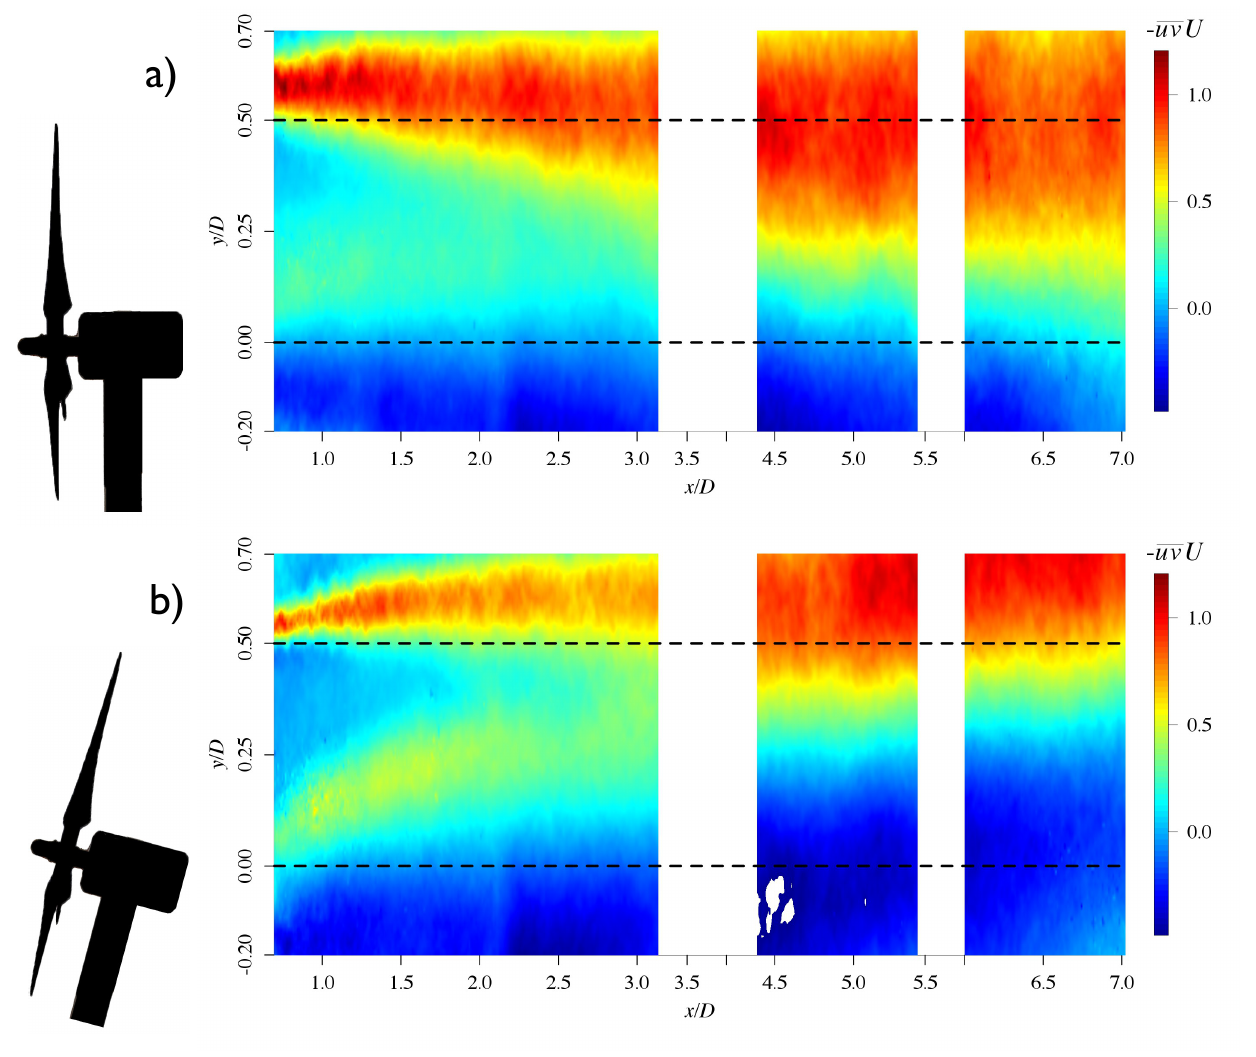
Figure 17. Contours for the flux of Reynolds shear stress − uvU for fixed ( a ) and floating ( b ) case. The flux of the shear stress represents the power that can be extracted. Hub height ( y/D = 0) and top blade tip ( y/D = 0.5) are indicated by dashed horizontal